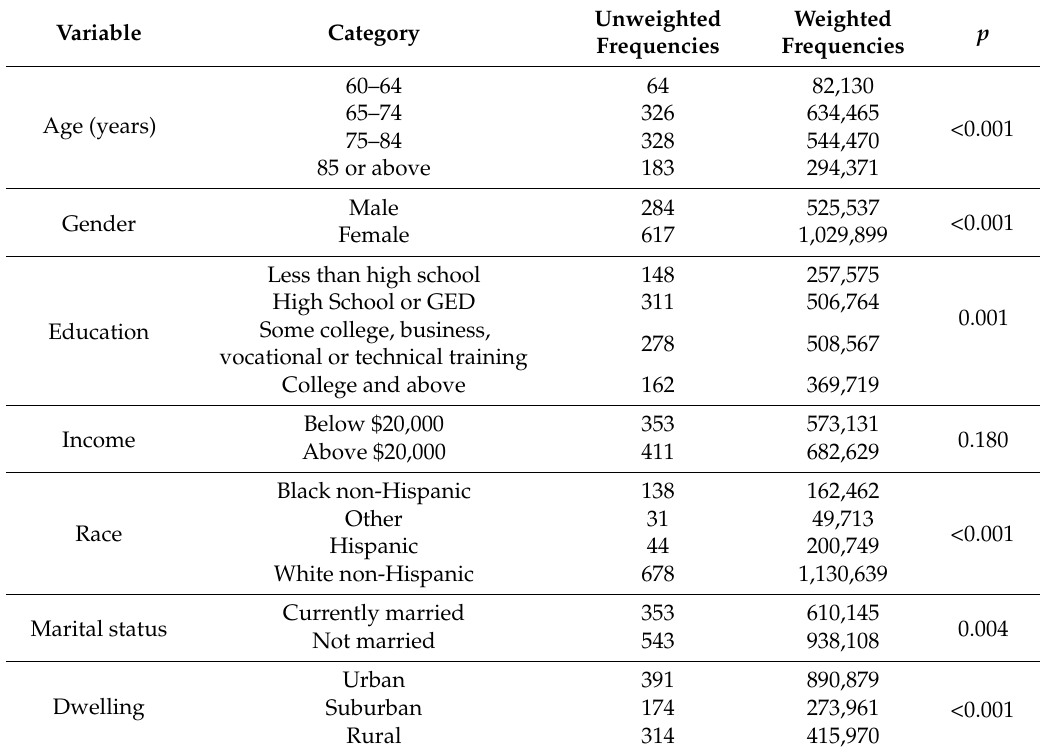
Table 1. Demographics of the